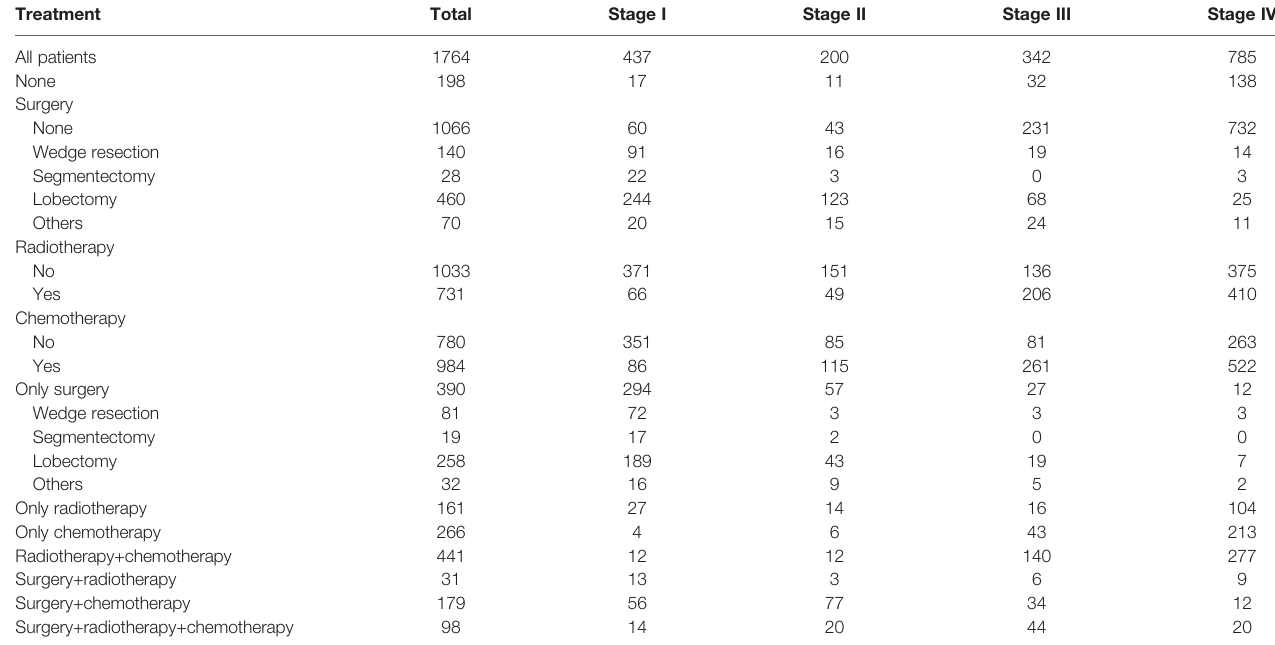
TABLE 5 | Distribution of patients with pulmonary large cell neuroendocrine carcinoma who had complete records of TNM stage (AJCC, seventh edition) and treatments using SEER 18 Regs Custom Data (with additional treatment fi elds; November 2018 Submitted). Treatment